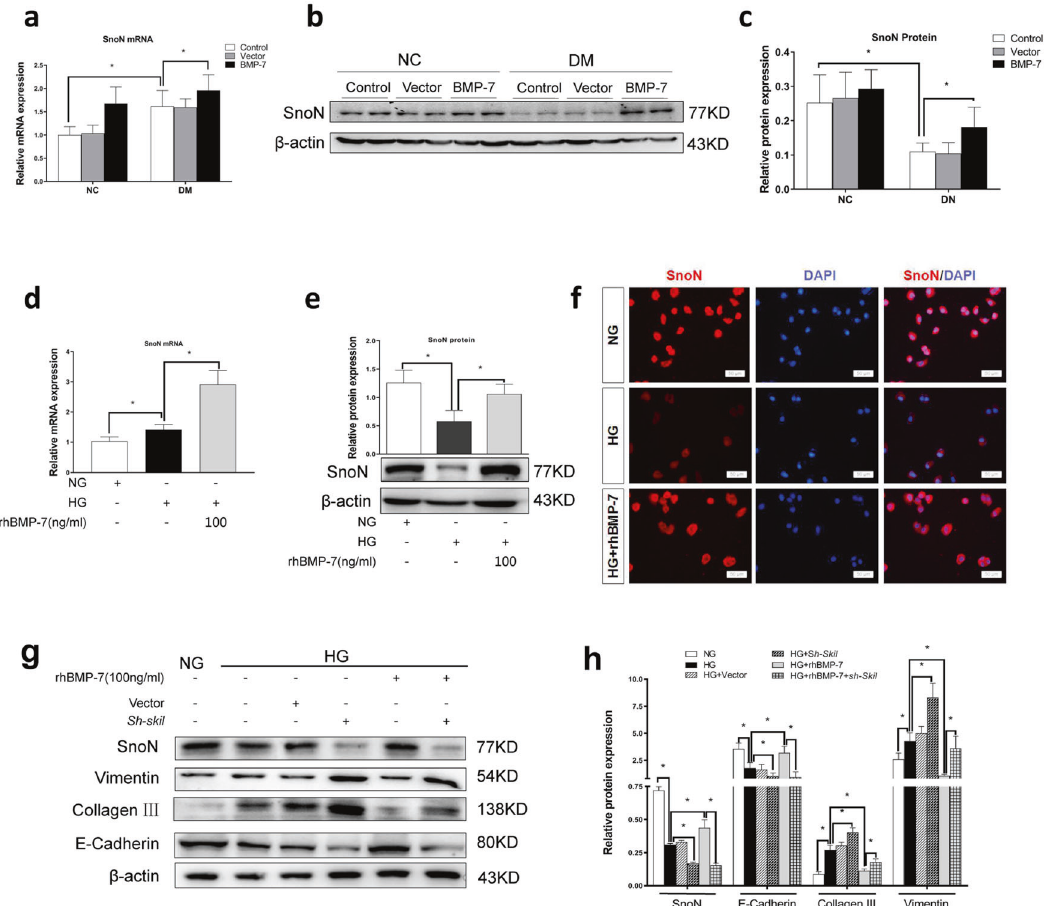
Fig. 4 BMP-7-restored SnoN protein countered renal fi brosis after diabetes. a Graphical presentations show the relative abundance of SnoN mRNA after normalization with β -actin mRNA analyzed by RT-qPCR in the kidney tissues in different groups, * P < 0.05 ( n = 6). b Western blotting and c quantitative data represent the expression of SnoN protein in the kidney tissues in different groups, * P < 0.05 ( n = 6). d Graphical presentations show the relative abundance of SnoN mRNA after normalization with β -actin mRNA analyzed by RT-qPCR in NRK-52E cells under different conditions, * P < 0.05 ( n = 3). e Western blotting and quantitative data represent the expression of SnoN protein in NRK- 52E cells under different conditions, * P < 0.05 ( n = 3). f Representative micrographs show immuno fl uorescence staining of SnoN in NRK-52E cells after incubation in different conditions. DAPI staining (blue) represents cell nucleus, Bar = 50 um. Knockdown of SnoN impaired the renoprotection of BMP-7 in NRK-52E cells under high-glucose conditions. g Western blotting and h quantitative data represent the expressions of E-cadherin, Collagen-III, and Vimentin in NRK-52E cells under different conditions, * P < 0.05 ( n =